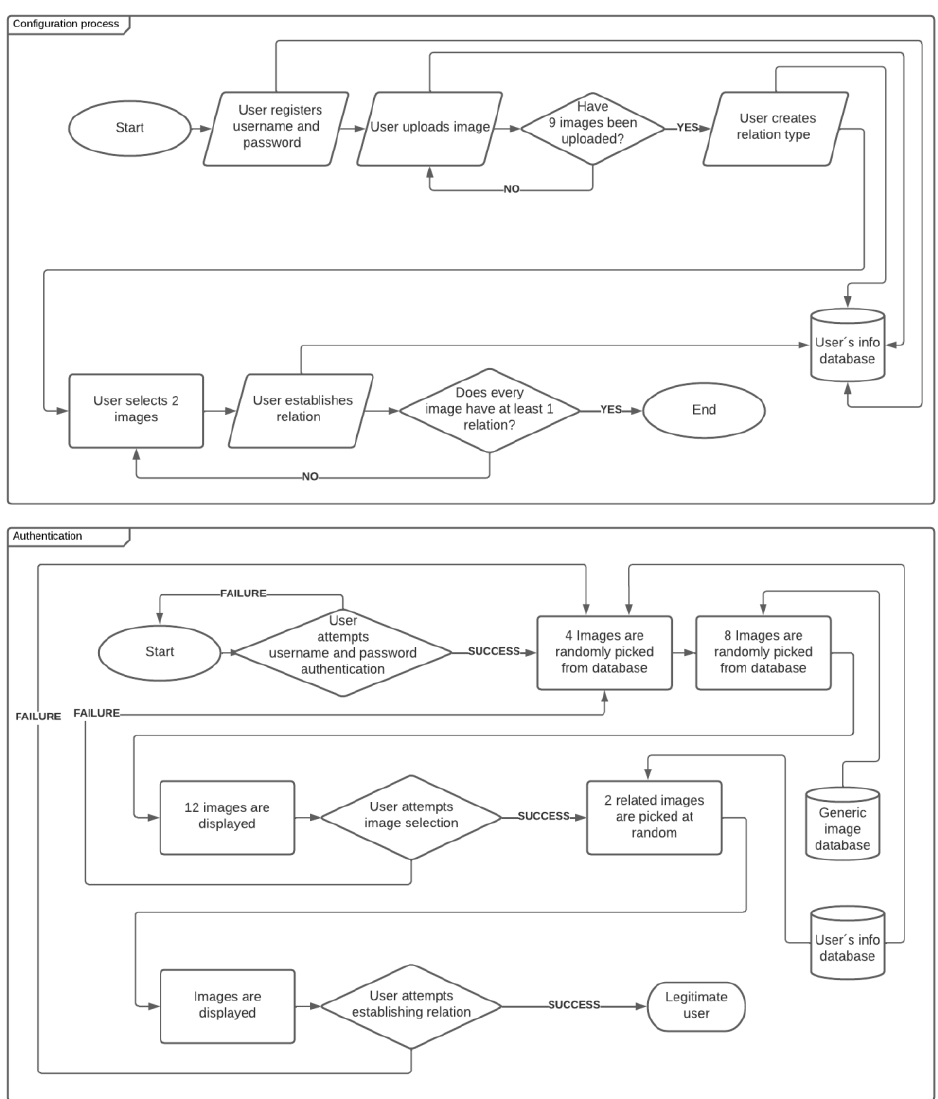
Figure 1. Flow chart for proposed mechanism.